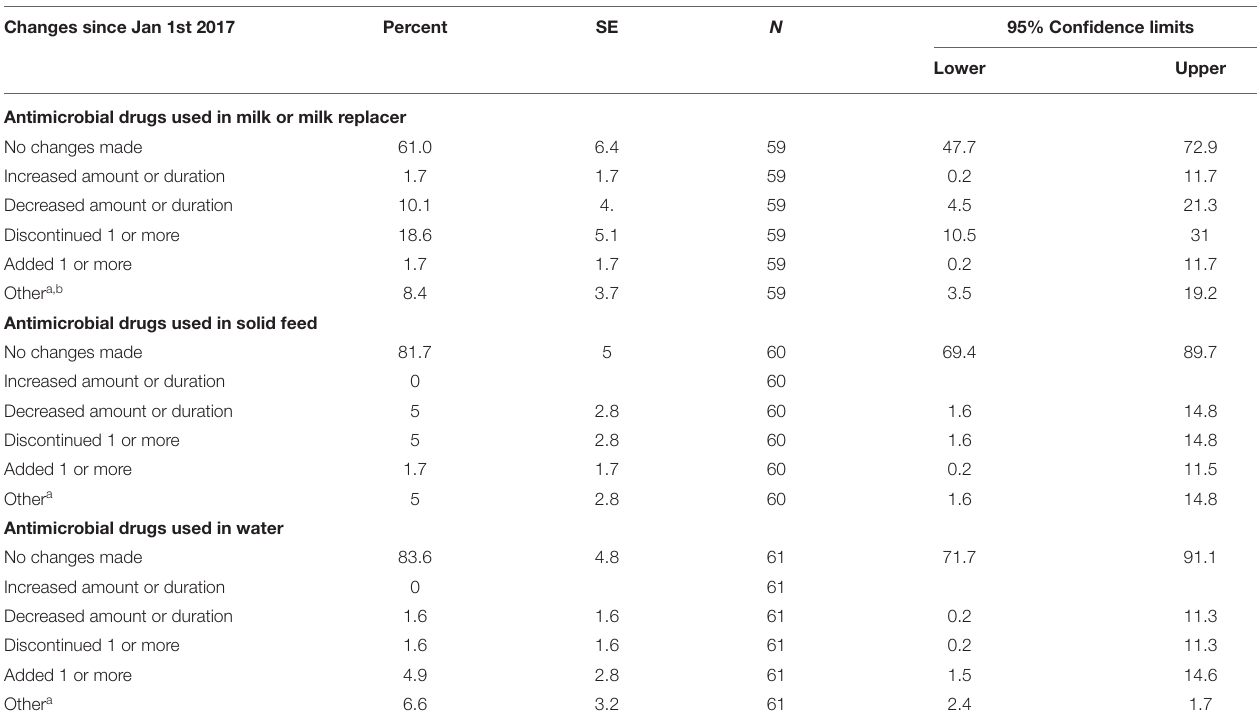
TABLE 3 | Changes in the use of antimicrobial drugs in preweaned calves on California dairies following the implementation of the Veterinary Feed Directive (VFD) final rule on January 1, 2017 compared to practices during the year 2016. Changes since Jan 1st 2017 Percent SE N 95% Confidence limits